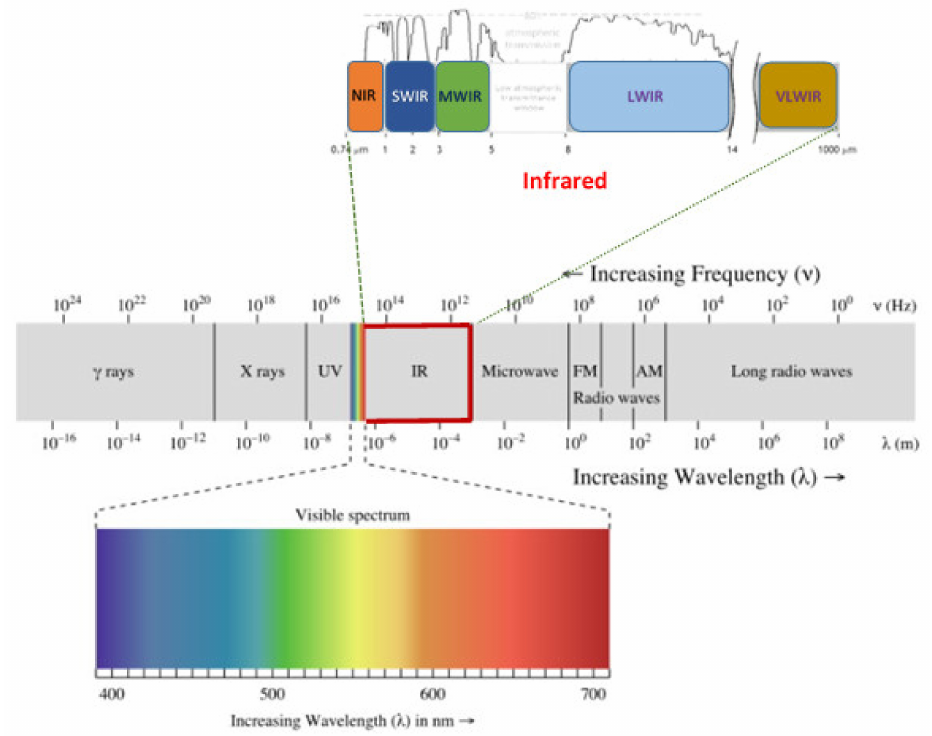
Figure 3. Different spectra of electromagnetic